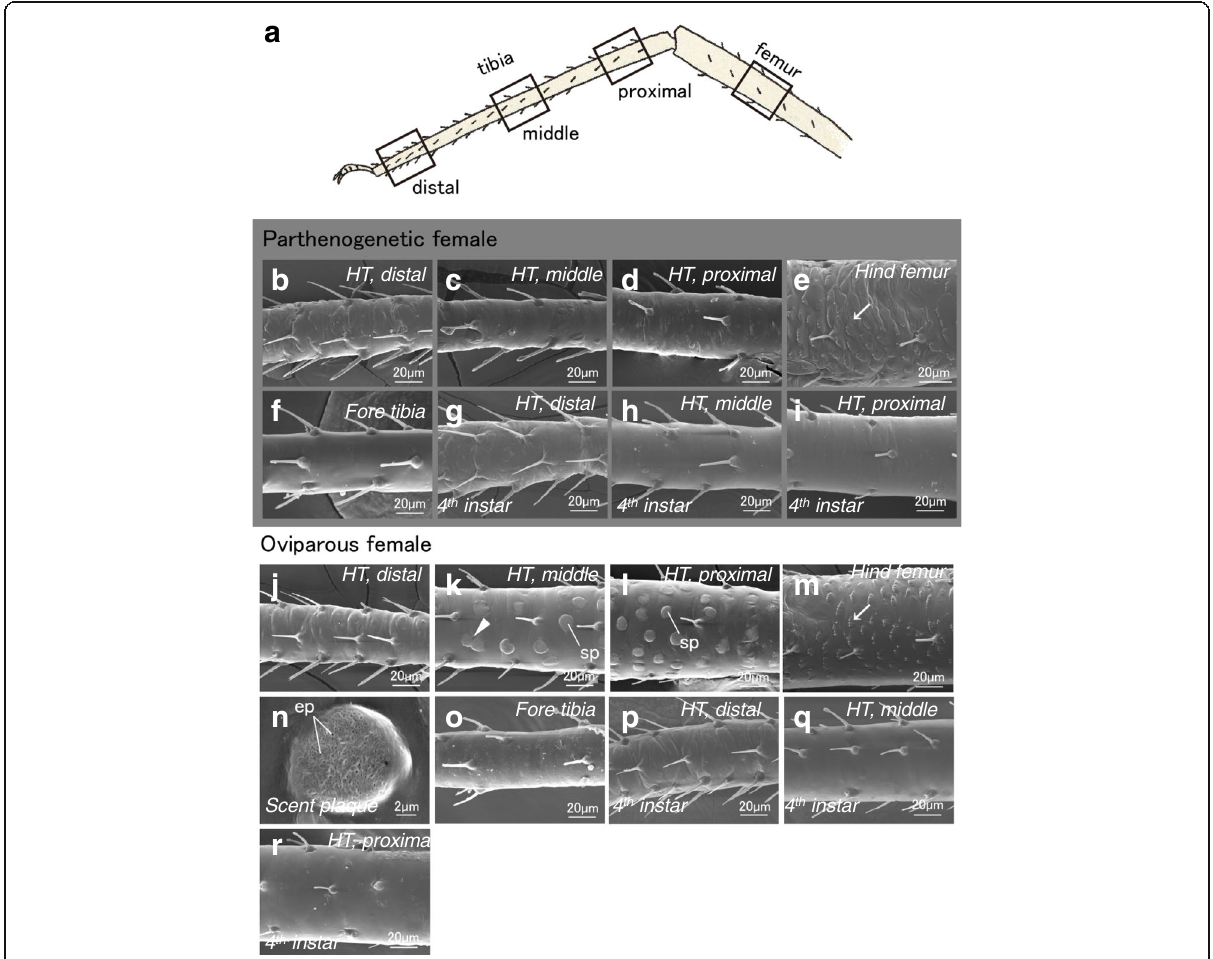
Fig. 2 Comparisons of leg surface structures between parthenogenetic and oviparous females. a : Outline of observed parts. b – d : Hind tibia of an adult parthenogenetic female (distal, middle, and proximal parts). e : Hind femur of an adult parthenogenetic female. f : Foreleg tibia of an adult parthenogenetic female. g – i : Hind tibia of a fourth-instar parthenogenetic female (distal, middle, and proximal parts). j – l : Hind tibia of an adult oviparous female (distal, middle, and proximal parts). m : Hind femur of an adult oviparous female. n : Magnification (× 10) of a scent plaque. o : Foreleg tibia of an adult oviparous female. p – r : Hind tibia of a fourth-instar oviparous female. Arrows indicate scale-like structures, and arrowheads indicate scent plaques showing an “ ∞ ” shape. sp.: scent plaque, ep: epicuticular